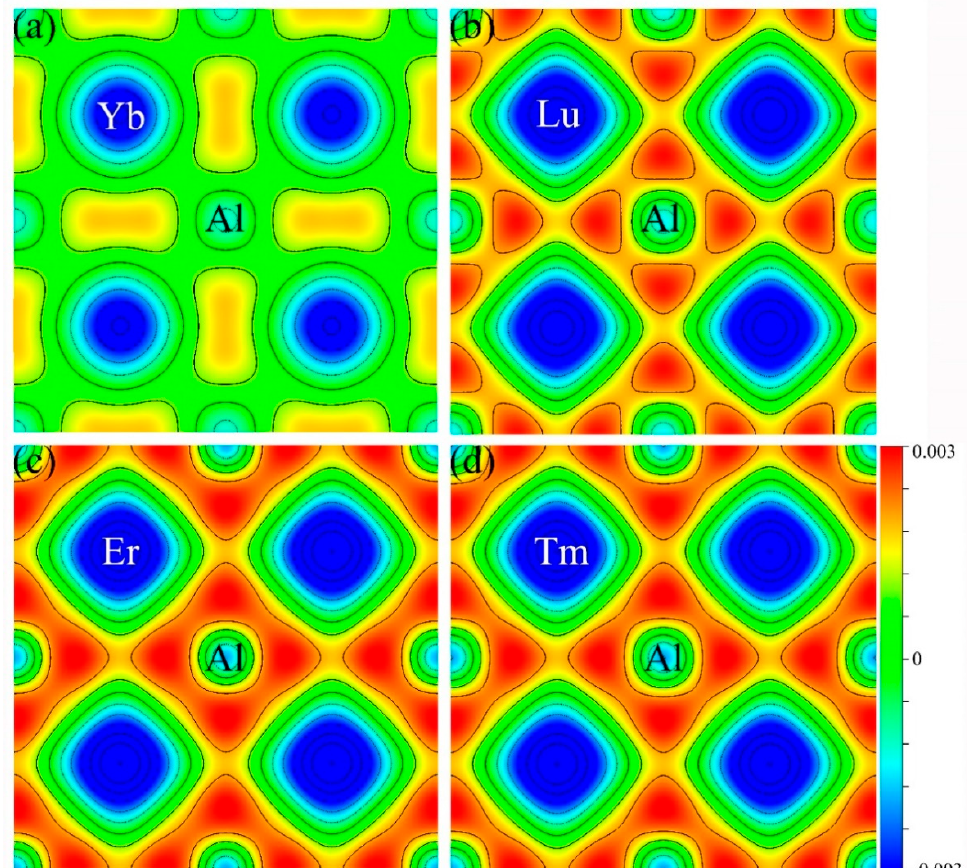
Figure 6. Charge density distribution of the L1 2 -Al 3 M phases in (100) plane: ( a ) Al 3 Yb, ( b ) Al 3 Lu, ( c ) Al 3 Er, and ( d ) Al 3 Tm. All the contour plots are on the same scale, and the interval between the contour lines is 0.001e/bohr 3 .